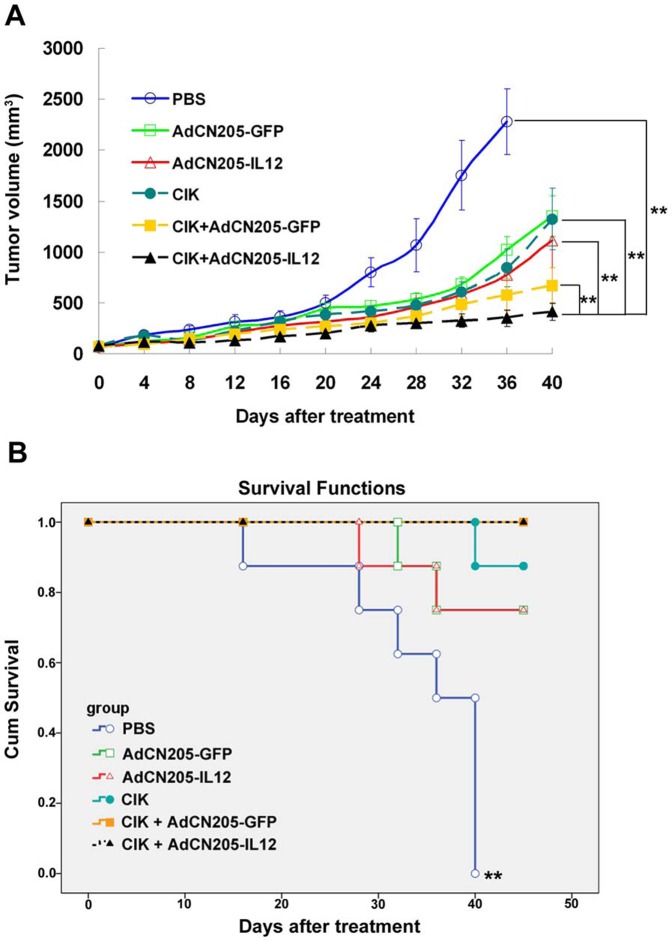
Antitumor activity in the established tumor in an animal model.Tumors were established by injection of HuH-7 cells s.c. into the right flank of SCID mice. The tumor-bearing animals were treated with either 2×108 ifu of different vectors by intratumoral injection or 1×107 CIK by intravenous injection, or combination of both treatment. PBS was used as control group. (A) The size of tumor was measured every 4 days and tumor volume was calculated. The data was presented as the mean ± SEM (n = 8). The result of student t test shown CIK plus AdCN205-IL12 group have extremely significant difference with PBS group (p = 0.0062), AdCN205-GFP group (p = 0.0058), AdCN205-IL12 group(p = 0.0098), CIK group (p = 0.0081), and CIK plus AdCN205-GFP group (p = 0.0052) (B) Kaplan-Meier survival. The result of log-rank statistical test shown PBS group have extremely significant difference with AdCN205-GFP group (p = 0.009), AdCN205-IL12 group(p = 0.01), CIK group (p<0.0001), CIK plus AdCN205-GFP group (p<0.0001) and CIK plus AdCN205-Il12 group (p<0.0001). The other group have no significant different with each other group.